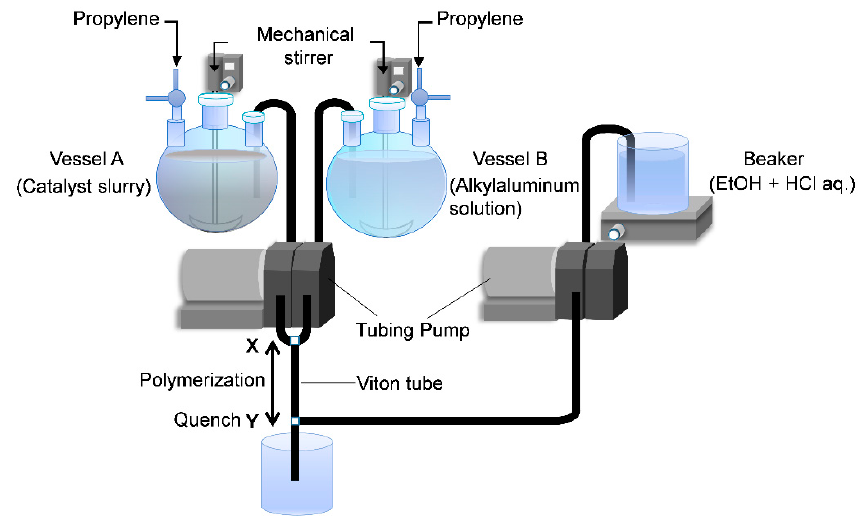
Figure 10. LSF apparatus with a new quenching method [38].